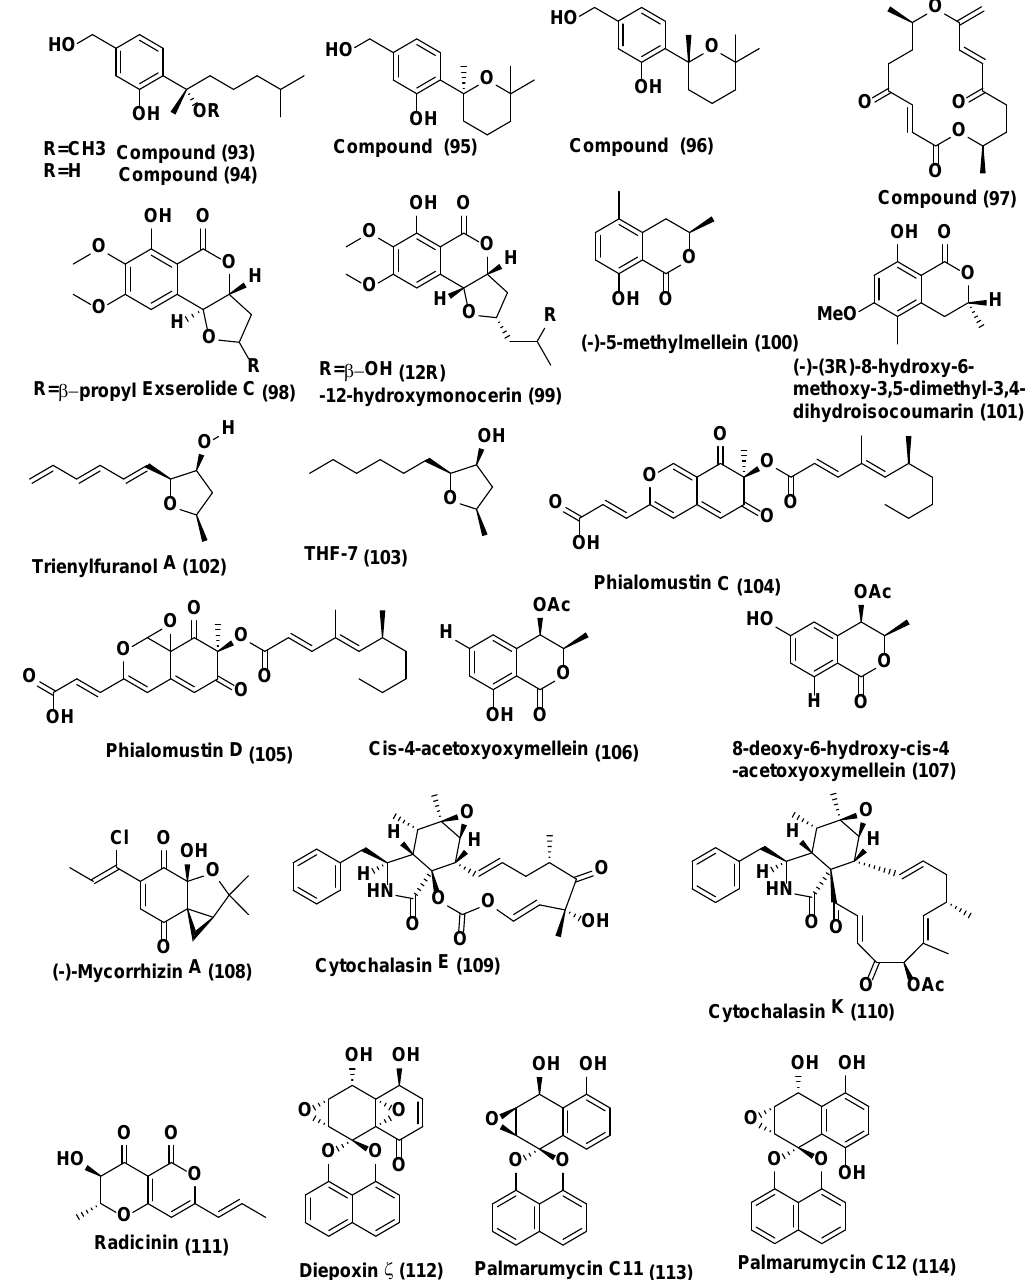
Figure 5. Structures of metabolites isolated from Ascomycetes ( 93 – 114 ).